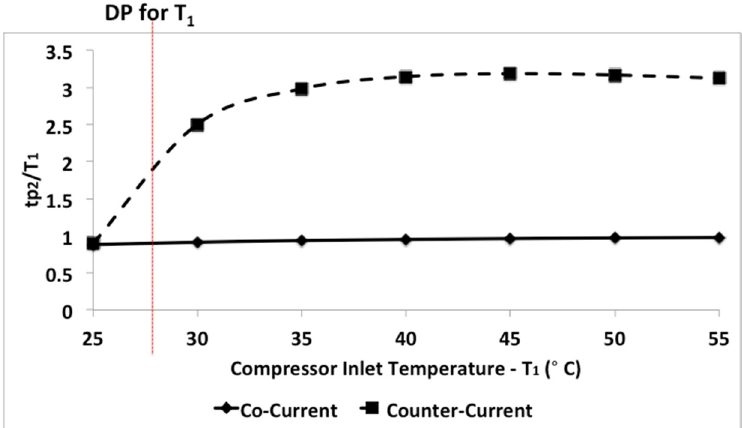
Figure 7. Heat Sink Outlet Temperature for SCR. The heat sink outlet temperature is normalised by the respective cycle/compressor inlet temperatures.